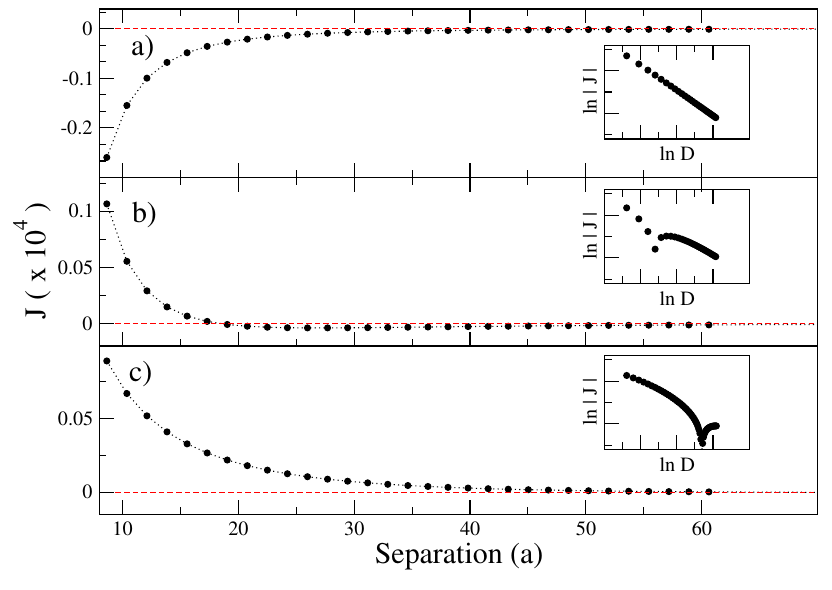
Figure 5. The magnetic coupling between two magnetic sites on the same sublattice as a function of their separation, D , along the armchair direction for three different impurity parameterisations: ( a ) ( m = 0 . 6 , δ = 0 . 0 , t ′ = t ); ( b ) ( m = 0 . 6 , δ = 5 . 0 t , t ′ = 0 . 8 t ) and ( c ) ( m = 0 . 6 , δ = 8 . 0 t , t ′ = 0 . 6 t ). The insets show log-log plots where a sign change in the coupling is evident from a dip